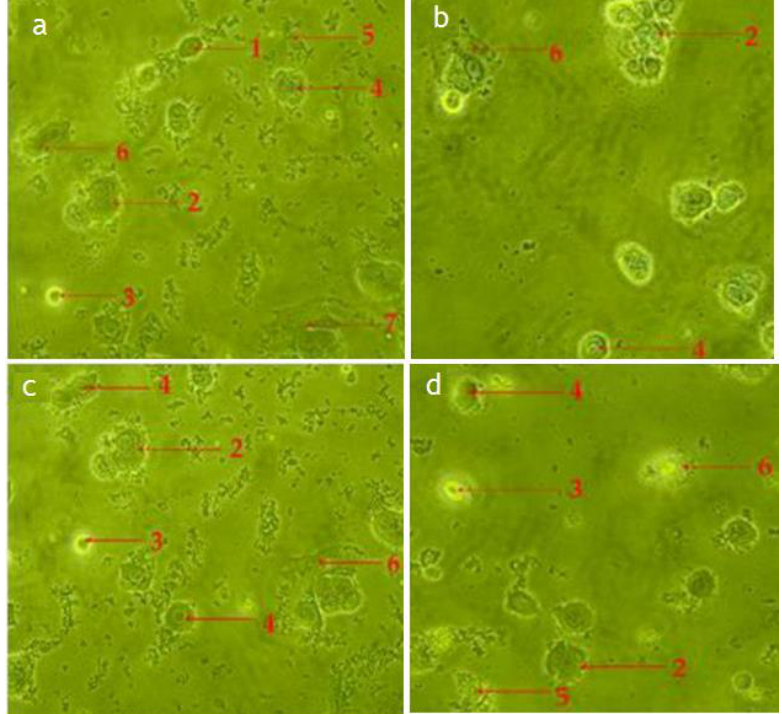
Figure 6. Photomicrograph shows morphological changes of MCF-7 cancer cells. MCF-7 cells treated with hexane fraction of C. minima —( a ): 45 µ g/mL; ( b ): 90 µ g/mL; and chloroform fraction of C. minima— ( c ): 50 µ g/mL; ( d ): 100 µ g/mL for 24 h and imaged by phase-contrast microscope (magnification 200 ×